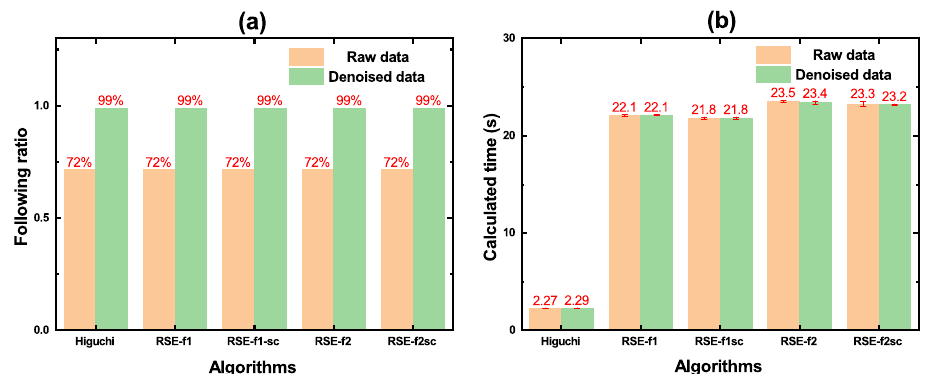
Figure 6. The results of the ( a ) following ratio and the ( b ) calculated time were illustrated by using various algorithms of raw and denoised data. The red lines represented the error bar, and red letters on each column represented the corresponding